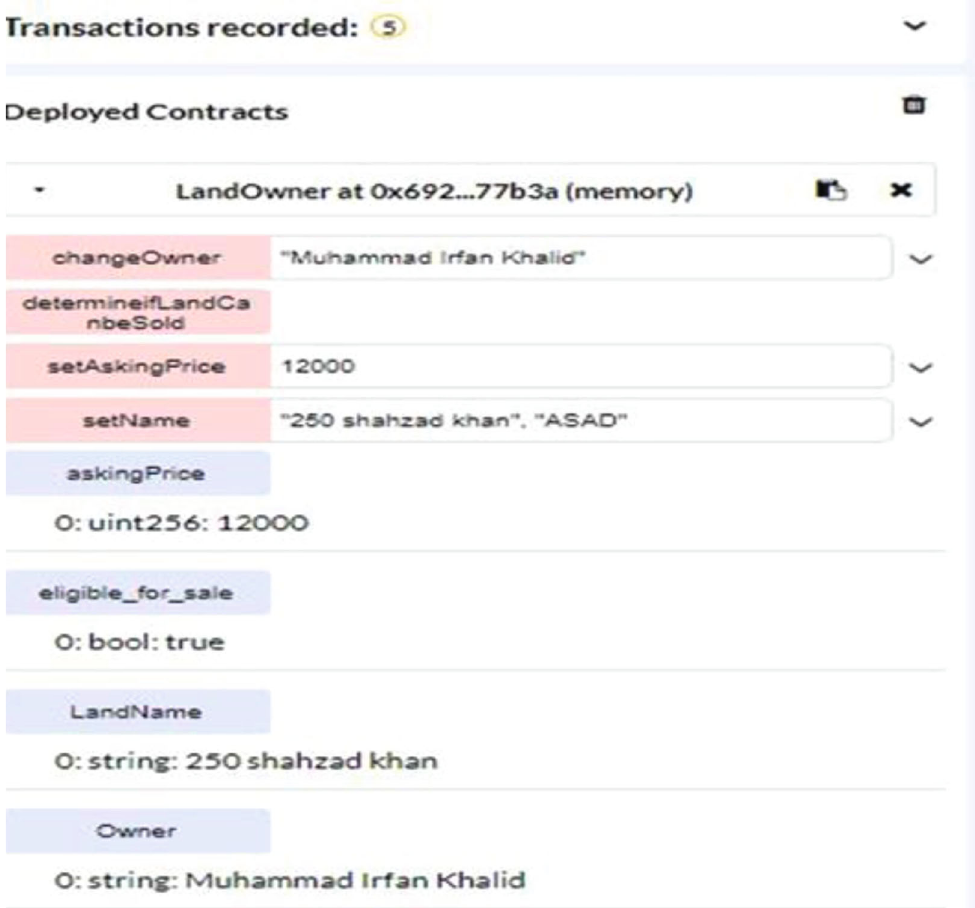
Figure 17: Transaction validation and block addition process.